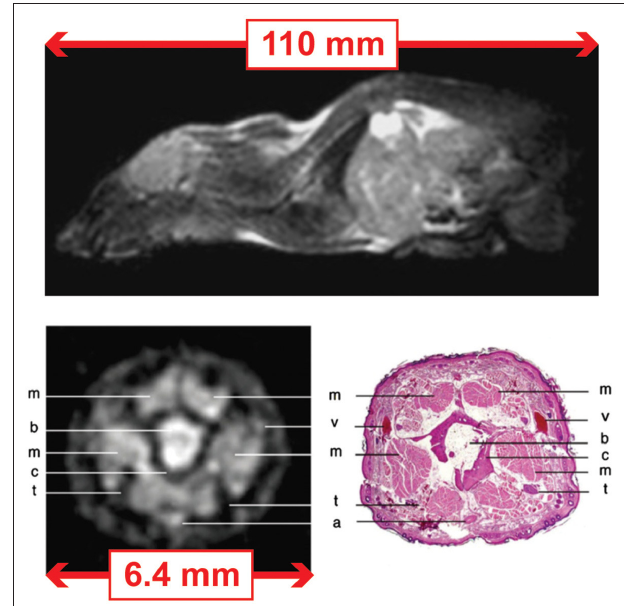
FIGURE 2 | MRI images of the mouse acquired at 0.1T using a FISP sequence and dedicated coils for the whole-body and tail. (Top) Whole body: field-of-view (FoV) of 110mm and in plane resolution of 430 acquisition time was 30min for 30 slices of field-of-view (FoV) of 6.4mm and in plane resolution of 100 acquisition time was 1h 30min for 26 slices of modified, with permission, from Choquet et al.